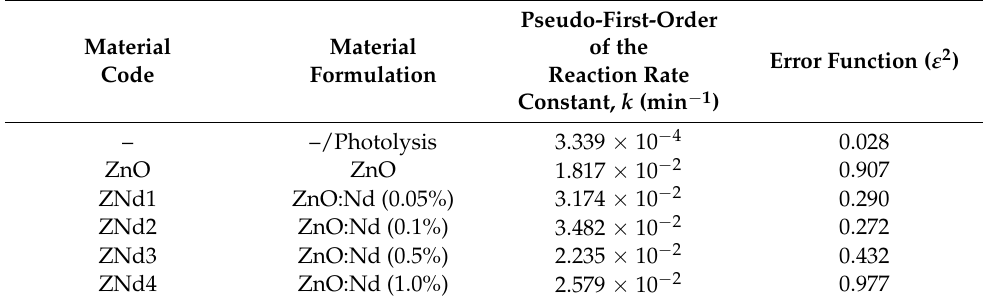
Table 2. Kinetic parameters for MB dye photodegradation under visible light in the presence of the produced catalysts (ZnO and